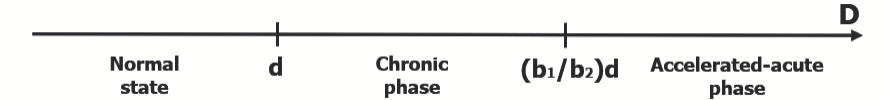
Figure 1. Diagram of the transition from the normal hematopoiesis to the chronic and accelerated-acute stages in myeloid leukemia. Values of D less than d correspond to the normal hematopoietic state; values of D between d and ( b 1 / b 2 ) d correspond to the chronic phase of leukemia; values of D larger than ( b 1 / b 2 ) d characterize the accelerated-acute phase of the disease.